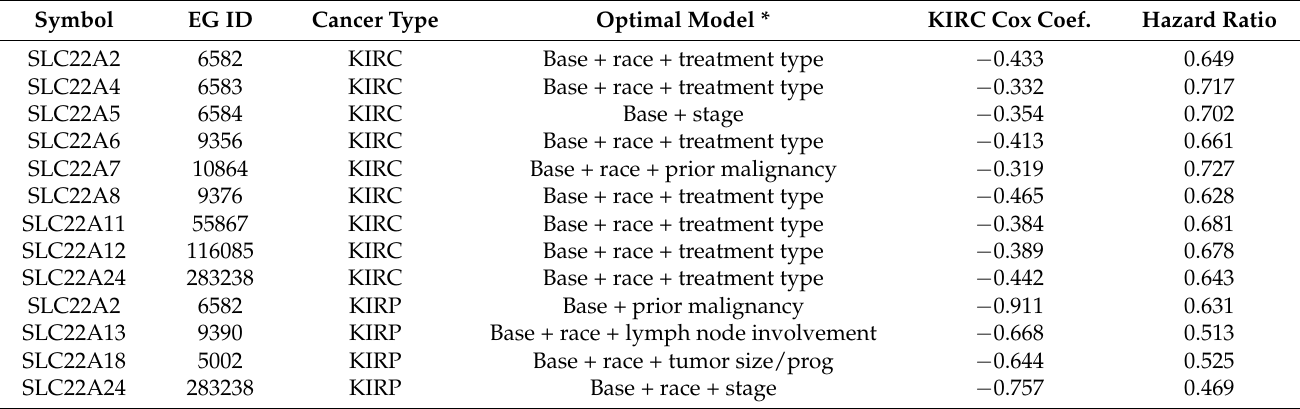
Table 1. SLC22 gene optimal Cox Proportional Hazards model